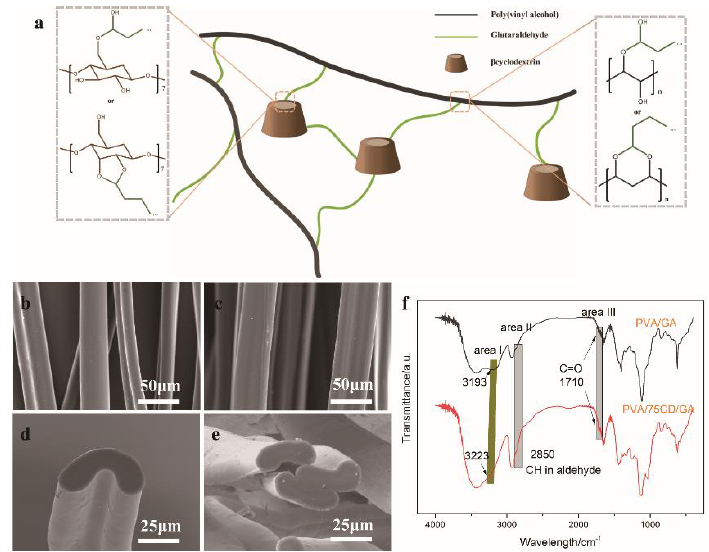
Figure 3. ( a ) Schematic illustration of PVA/CD fibers crosslinked with GA; ( b ) SEM images of PVA/GA fibers; ( c ) SEM images of PVA/75CD fibers; ( d ) cross-section SEM images of PVA/GA fibers; ( e ) cross-section SEM images of PVA/75CD/GA fibers; FTIR of PVA/GA and PVA/75CD/GA fibers; ( f ) FTIR spectra of acetylated fibers.